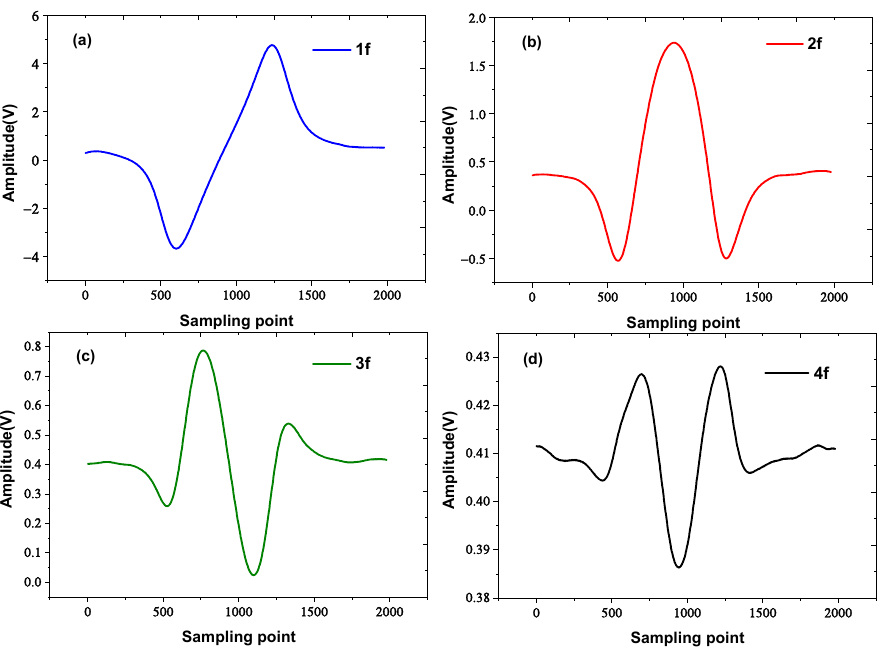
Figure 5. The harmonic component signal was obtained by demodulation of the lock-in amplifier. ( a ) 1 f signal; ( b ) 2 f signal; ( c ) 3 f signal; ( d ) 4 f signal. The 400 ppm CO 2 and pure N 2 were mixed into the CO 2 sample gas with different concentrations of 100 ppm, 200 ppm, 300 ppm, and 400 ppm, respectively, by the mass flow controller (Sevenstar D07-7B). At the same room temperature of 23 ◦ C and gas pressure of 90 Torr, the prepared sample gas was passed into the cavity, and a 2f signal was collected with the acquisition card for an average of 1000 times, as shown in Figure 6. The higher the concentration of sample gas, the greater the amplitude of the 2f signal.